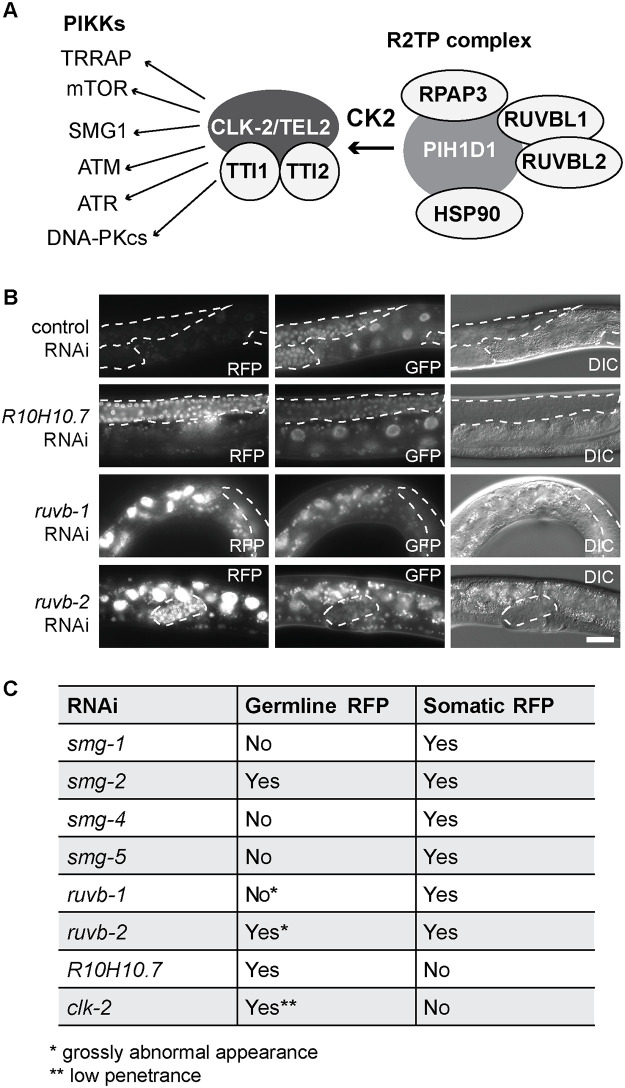
CLK-2 related factors affect the expression of NMD reporter.(A) Mammalian components of the R2TP complex and targeted PIKKs. Putative C. elegans counterparts are in parentheses: CK2 (kin-3 or kin-10), TEL2 (clk-2), RPAP3 (rpap-3), TTI1 (R10H10.7), TTI2 (C28H8.3, with a weak similarity), SMG1 (smg-1), HSP90 (hsp-90), RUVBL1 (ruvb-1), and RUVBL2 (ruvb-2). (B) Partial view of animals, carrying the R-2 reporter, subjected to RNAi as indicated. Scale bar = 20 μm. Germline tissue is highlighted by dotted lines. (C) Summary of NMD defects, upon RNAi-mediated depletion of indicated factors, examined in animals carrying the R-2 reporter.